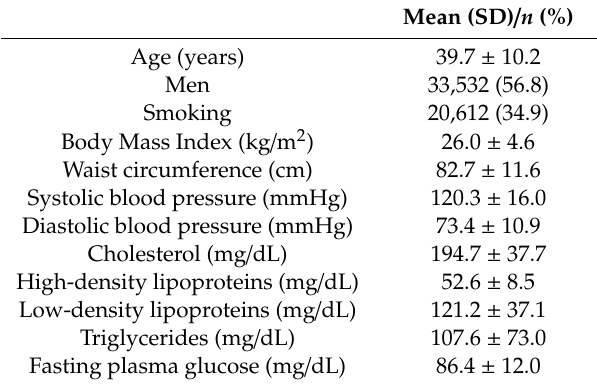
Table 3. Baseline participants’ characteristics ( n =